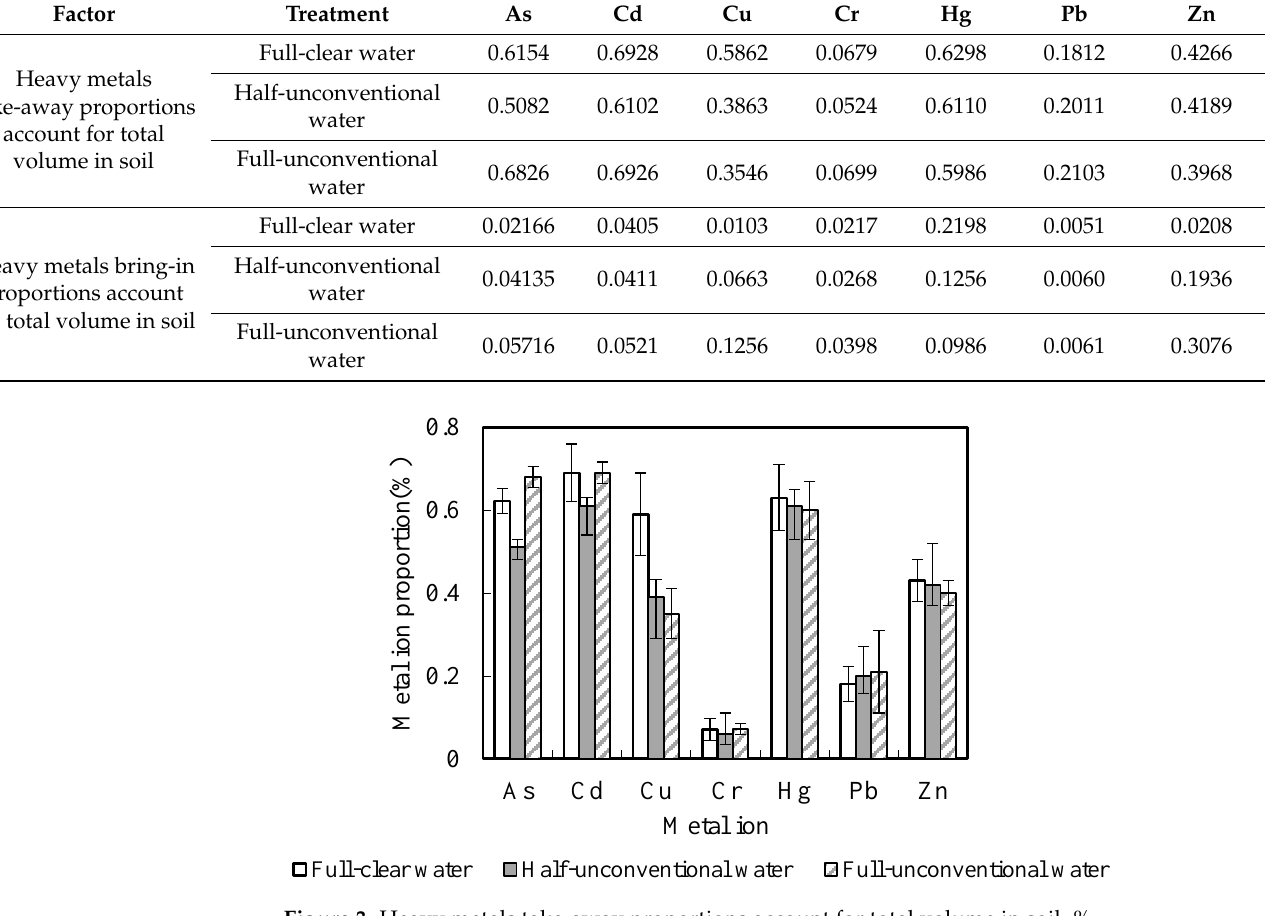
Table 6. During the cucumber growth season, proportion of changes in the amounts of heavy metals in soil before and after cucumber harvest %.